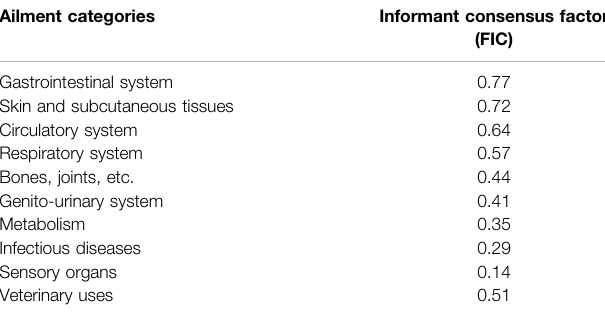
TABLE 5 | FIC values of category of ailments.